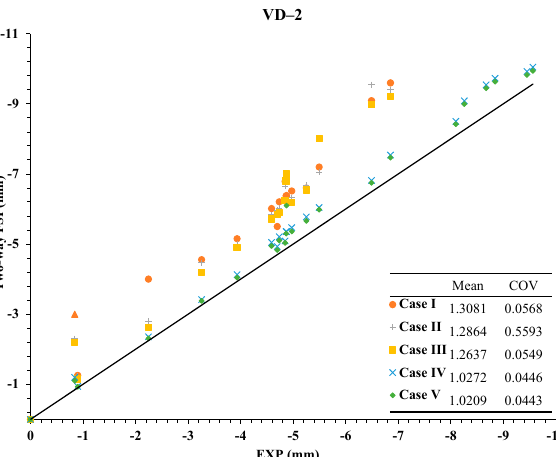
Figure 27. Statistical analysis of two-way FSI for deflection versus time increments ( ∆𝑡 ) at VD-2.